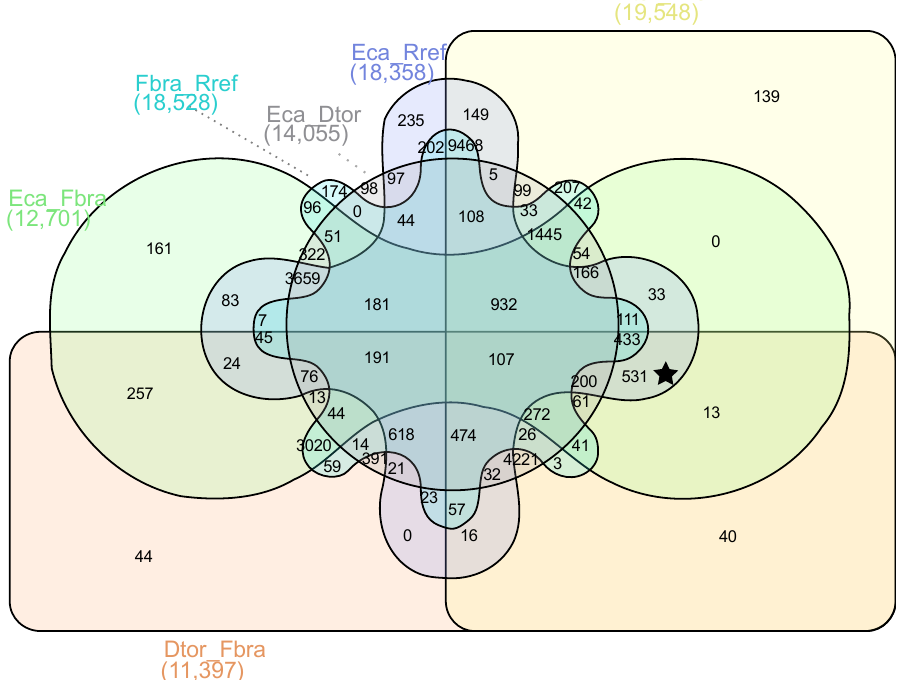
Figure 3. Venn diagram showing the number of DEGs with log 2 FoldChange > 2 and < − 2 be- tween the different pairs of species studied. The crossing area indicates the cross-DEGs in different data sets. The star indicates the crossing area, showing the number of DEGs between species with different apertural systems, colpate ( E. californica and D. torulosa ) and porate ( R. refracta and F. bracteosa ), but not differentially expressed between species with the same apertural system. Dtor, Dactylicapnos torulosa ; Eca, Eschscholzia californica ; Fbra, Fumaria bracteosa ; Rref, Roemeria refracta .